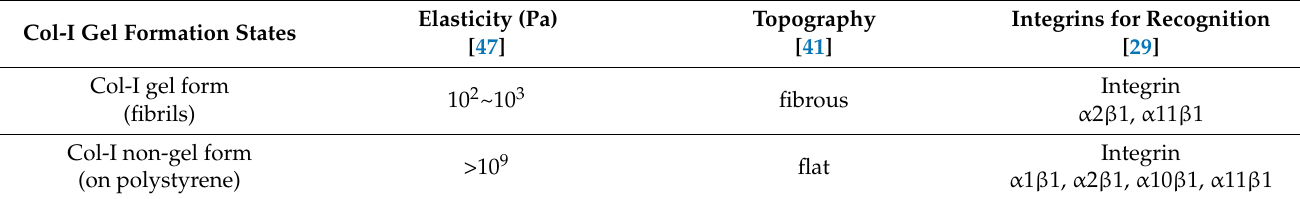
Table 1. Characteristics of the gel-forming state of